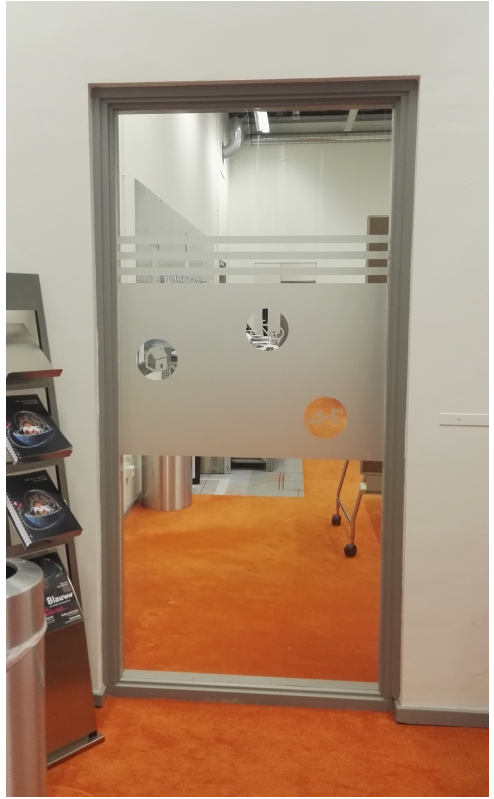
Figure 15. False door with a glass